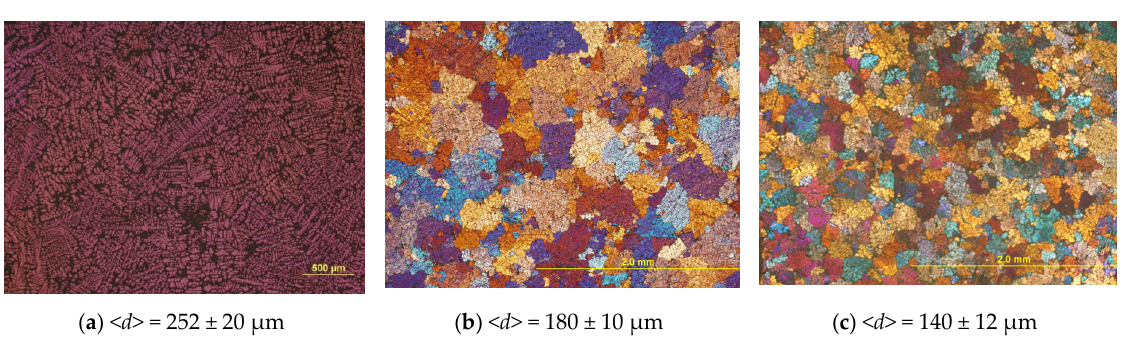
Figure 3. Microstructure of А 356 aluminum alloy: ( a ) initial А 356 alloy, ( b ) А 356 alloy after vibration, and ( c ) А 356 + 0.5 wt% TiB 2 after vibration treatment.